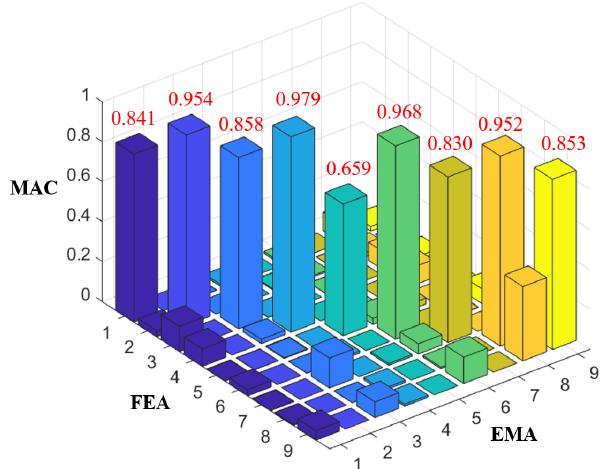
Figure 36. Typical plot of the modal assurance criterion (MAC) for the mode shapes obtained from the experimental modal analysis (EMA) and finite element analysis (FEA) of the